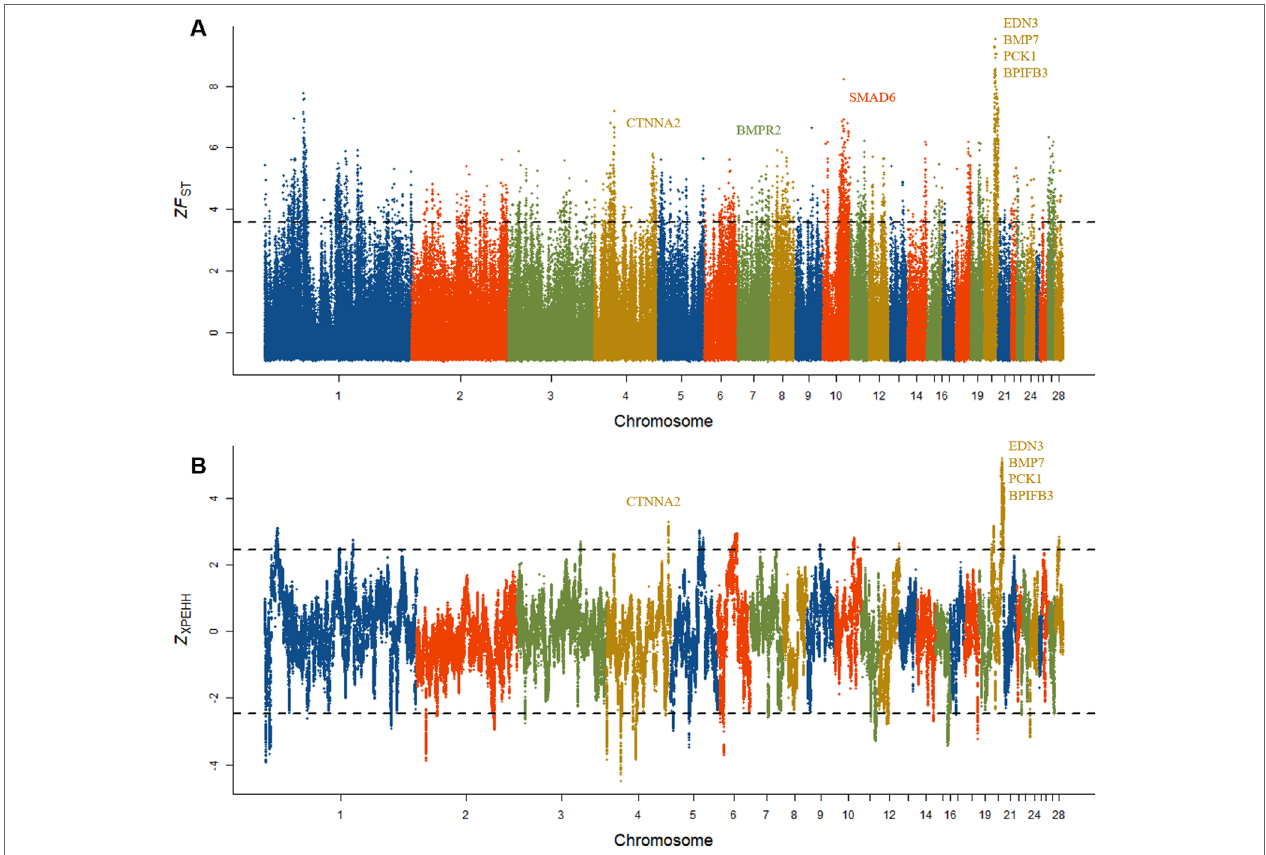
FIGURE 5 | Signature of selection in Dongxiang blue-shelled chicken. (A) Genomic landscape of signature of selection as measured by population differentiation ( F ST ) in pairwise comparisons of DCL and RCL and the outlier SNPs on chromosome 20 showing extremely high ZF ST values harboring EDN3 and BMP7 genes. (B) Genomic distribution of signatures of selection as measured by cross-population extended haplotype homozygosity (XP-EHH) test.